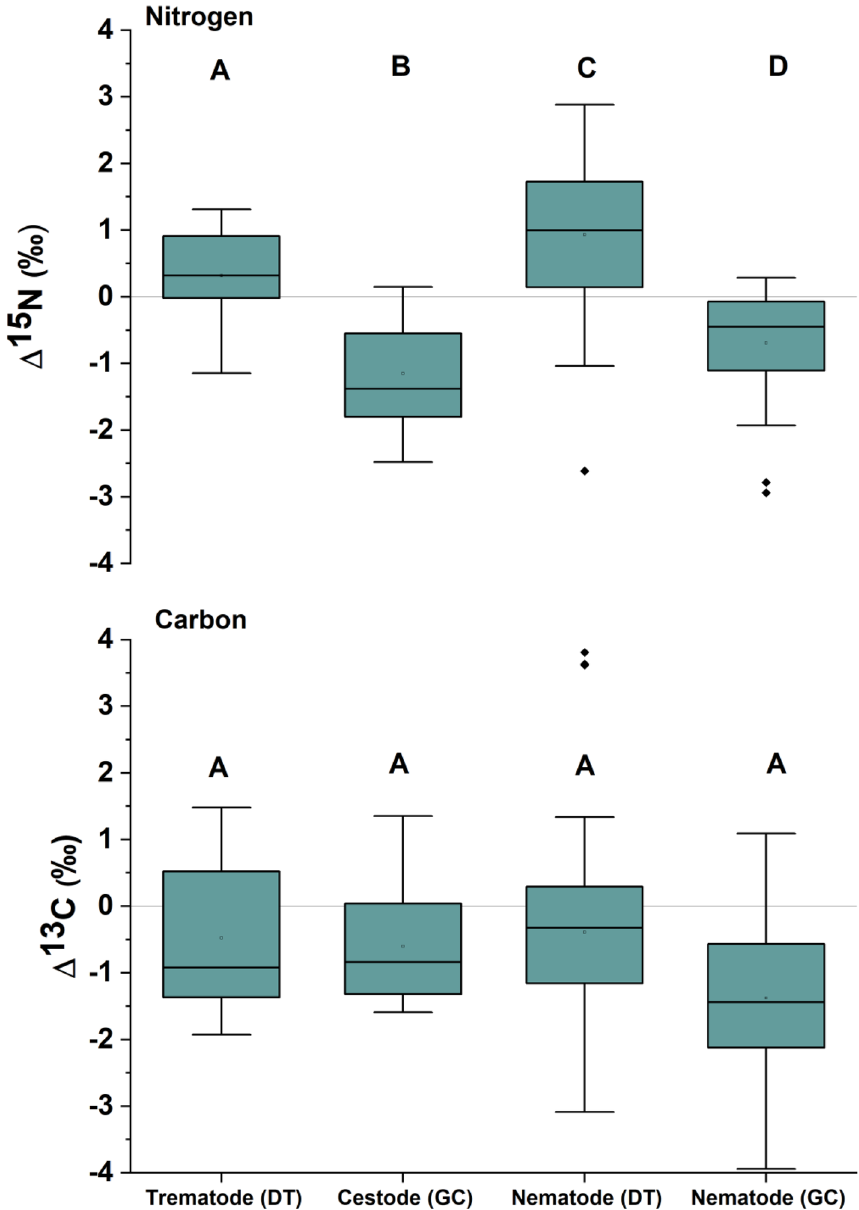
Figure 3. Δ 15 N and Δ 13 C values (‰) for trematodes and cestodes, and nematodes separated by parasite habitat within host. Letters indicate significant differences (post hoc Tukey’s test, α = 0.05). Dietary tract (DT) and general cavity (GC) refer to the parasite habitat within fish hosts. For the boxplots, black dots indicate mean, lines indicate median, boxes indicate upper and lower quartiles, and whiskers indicate 1.5 quartile ranges. Black diamonds are